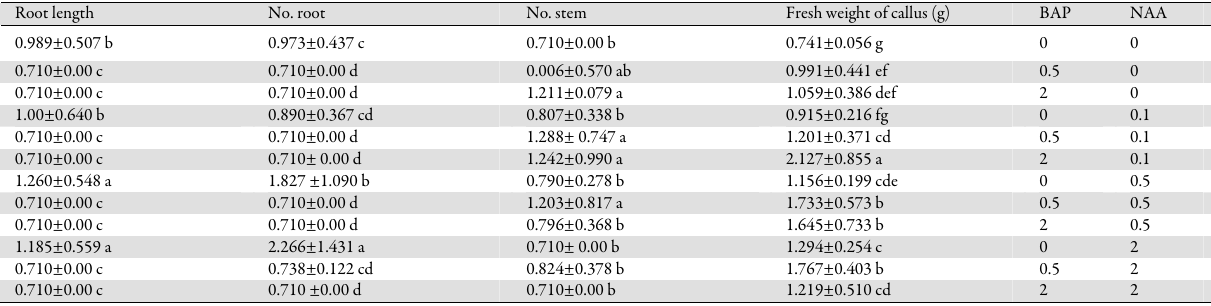
Table 2. The effect of growth regulators on callus, shoot and root induction of A . annua on MS medium Root length